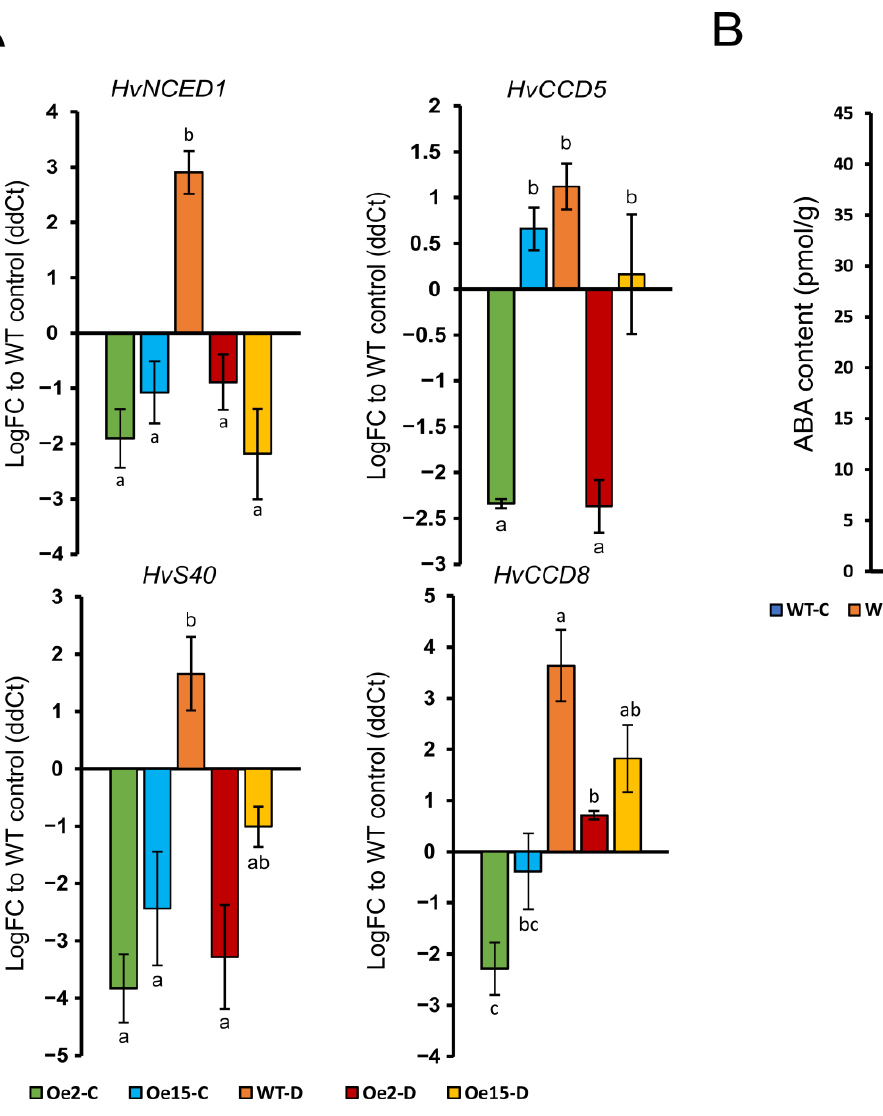
Figure 2. Expression of ABA biosynthesis-related genes and ABA levels in drought-stressed primary leaves (28 das) of WT and WHIRLY1 overexpression lines 2 and 15 compared to leaves of control plants. ( A ) Changes in relative expression level of senescence- and stress-related gene HvS40 and of ABA biosynthesis-related genes ( HvNCED1 , HvCCD5 and HvCCD8 ) measured via qPCR. Each bar represents the mean value from 3 replications, and the error bar shows the SEM. ( B ) ABA concentration of primary leaves at 29 das. Each bar represents the mean value from 3 separate replicates, and the error bar shows the standard error of the mean (SEM). Different letters above the graph bars in A and B designate statistically significant differences according to two-way ANOVA using Tukey’s HSD test with p <